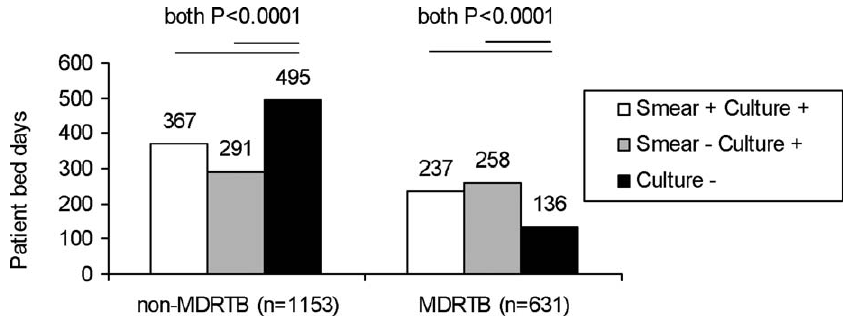
Figure 2. Pulmonary TB Patient Bed Days According to Sputum Smear Status and TB Drug Susceptibility The numbers of patient bed days accounted for by patients with MDR TB, or with non-MDR TB, are shown. Results are subdivided into sputum-smear positive and culture positive (white shading); sputum-smear negative and culture positive (dark grey shading); and culture negative (black shading). Two patients are not included in this figure: one culture-positive patient with drug-susceptible TB (accounting for 6 patient days) with an unavailable smear result; and one smear-negative, culture-positive patient (accounting for 8 patient days) with no TB drug-susceptibility information. The drug- resistant category included 32 MDR TB cases and 12 isoniazid or rifampicin monoresistant cases. In non-MDR TB admissions, 34 smear-negative culture- positive and 241 culture-negative patient bed days were accounted for by patients treated empirically, without confirmation of drug-susceptibility status in our laboratory. In MDR TB admissions, 45 smear-negative culture-positive and 98 culture-negative patient days were accounted for by such patients. Comparisons between groups were made using the two-sample z-test of proportions.